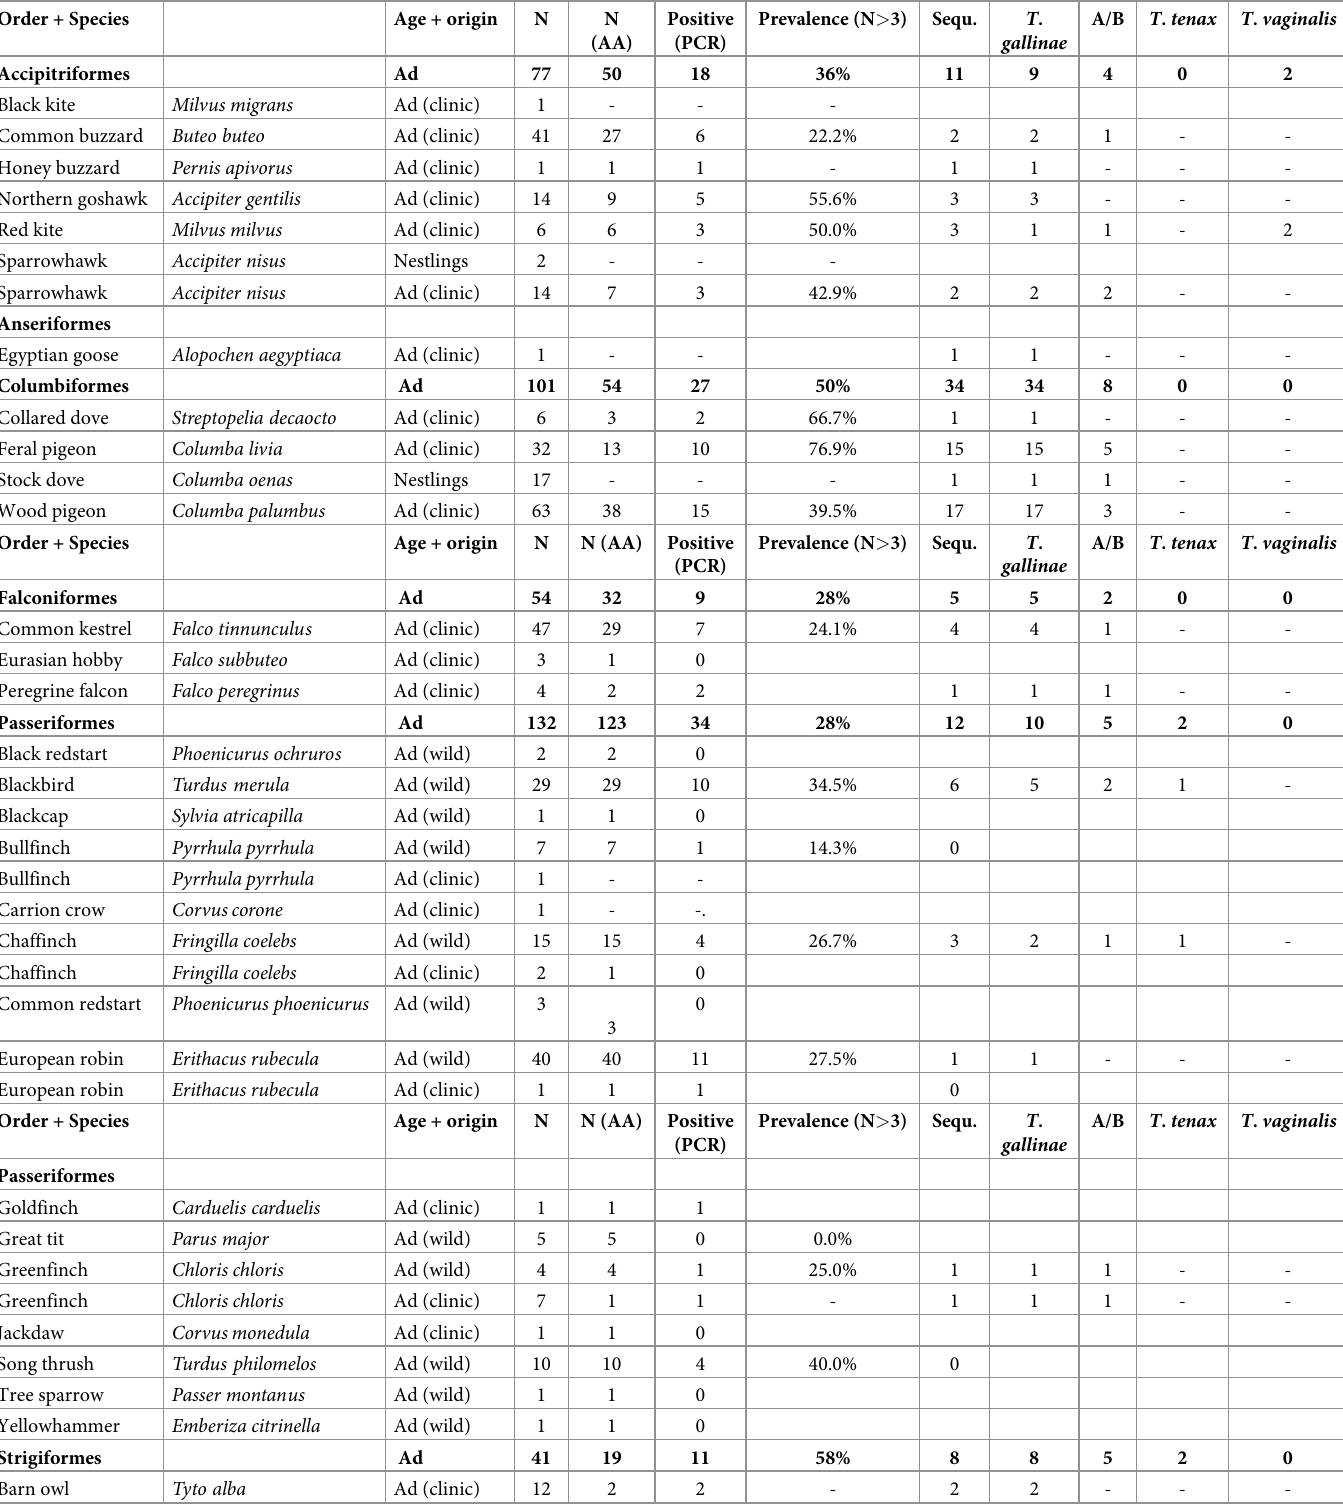
Table 1. Prevalence of Trichomonas infection in adults of 35 bird species (including nestlings and adults, Ad) with sampling origin in Hesse, Germany. Order +